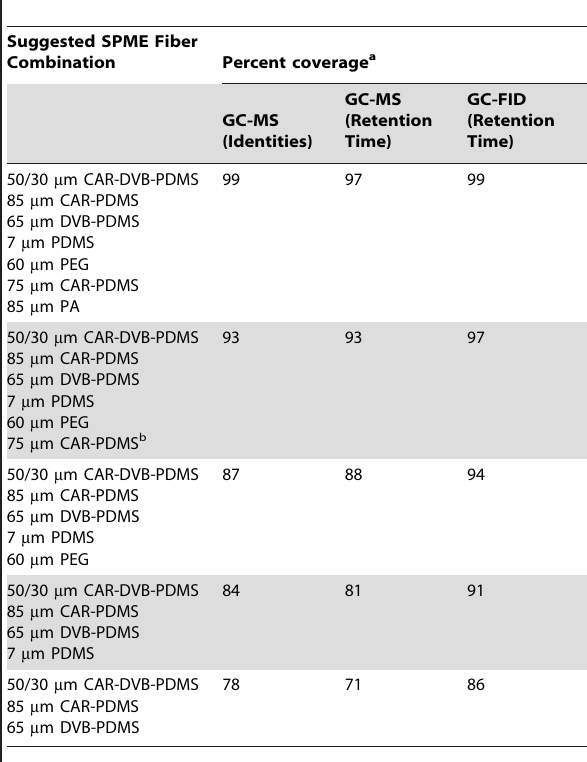
Table 4. Recommended fiber